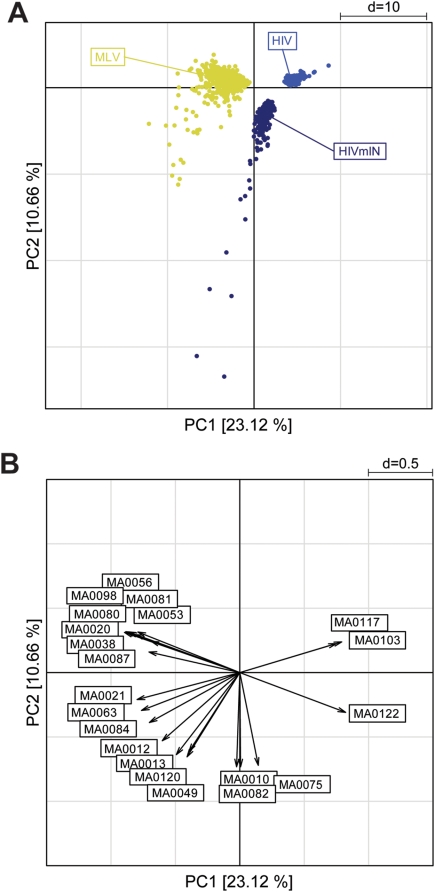
Principal component analysis of likelihood ratio values from the Clover analysis of the 49 JASPAR motifs enriched around integration sites of an MLV vector, an HIV vector and an HIV vector packaged with an MLV integrase (HIVmIN) in HeLa cells.(A) The scatter plot of the first two PCs (assessing 33.78% of total variability) reveals three main groups, corresponding to the vector type. The first component, accounting for 23.12% of the total variability, discriminates MLV from HIV sequences. The second component discriminates HIV from HIVmIN sequences but does not distinguish MLV from HIVmIN sequences. (B) The corresponding loading plot shows a set of MLV-specific motifs (MA0056, MA0098, MA0081, MA0080, MA0053, MA0020, MA0038 and MA0087), and a second group of motifs in common between HIVmIN and MLV sequences (MA0084, MA0063, MA0021, MA0012, MA0120, MA0013 and MA0049). All motifs are identified in Figure 5.